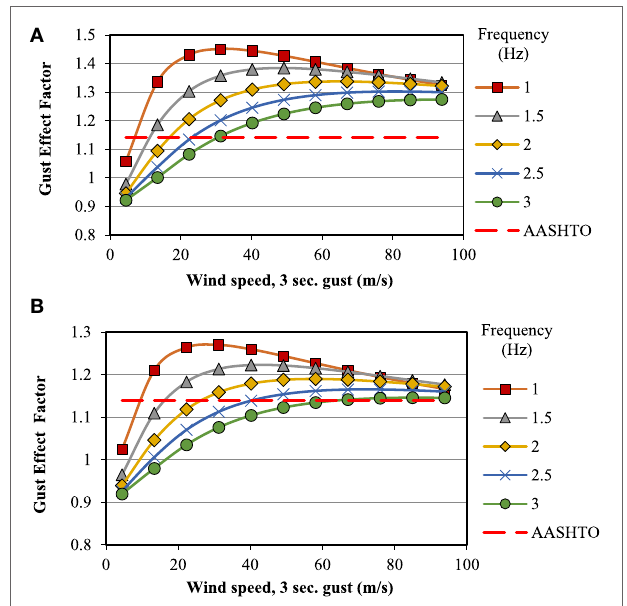
FIGURE 10 | Estimated gust effect factor for small sign: (A) heavier weight; (B) lighter